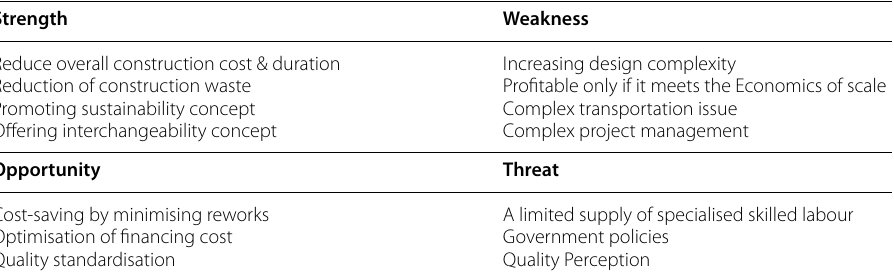
Table 2 SWOT analysis for modular construction concept (Company and Modular construction: From projects to products [Internet]. 2019